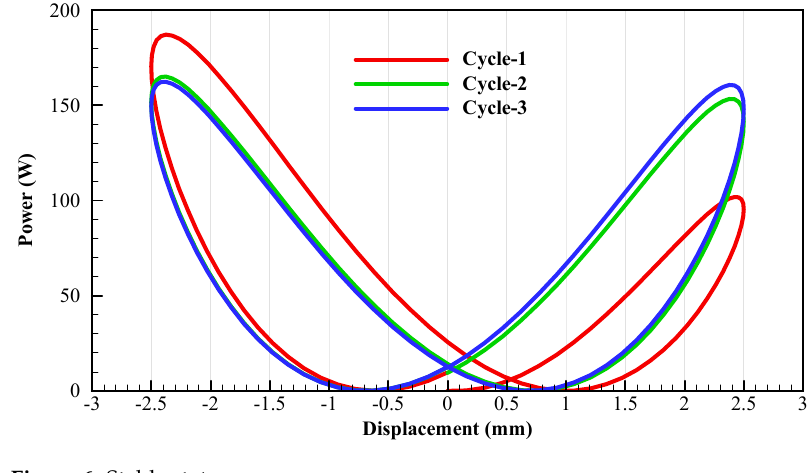
Figure 6. Stable state power.